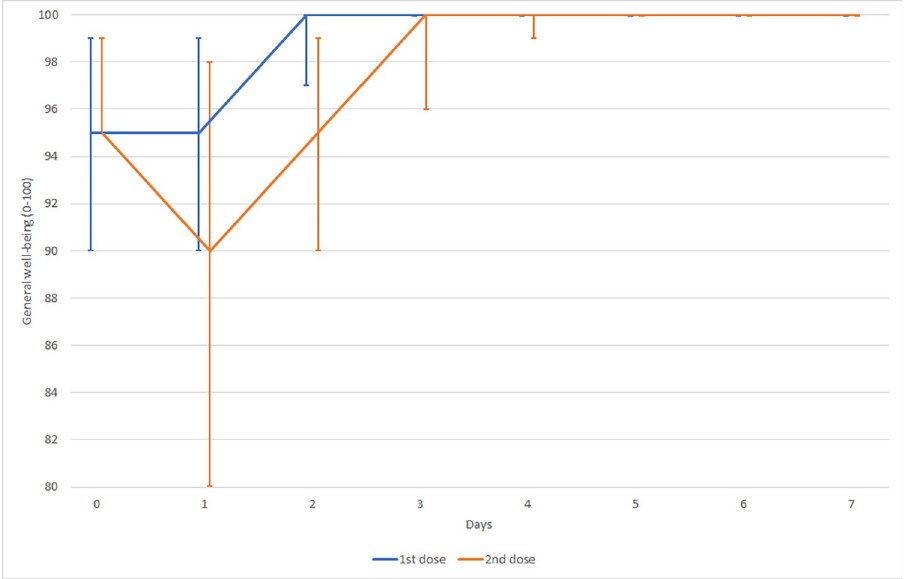
Fig 5. General well-being after SARS-CoV-2 vaccination—development in time.